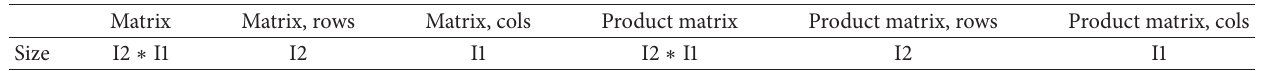
Table 5: Matrix size determination for matrix